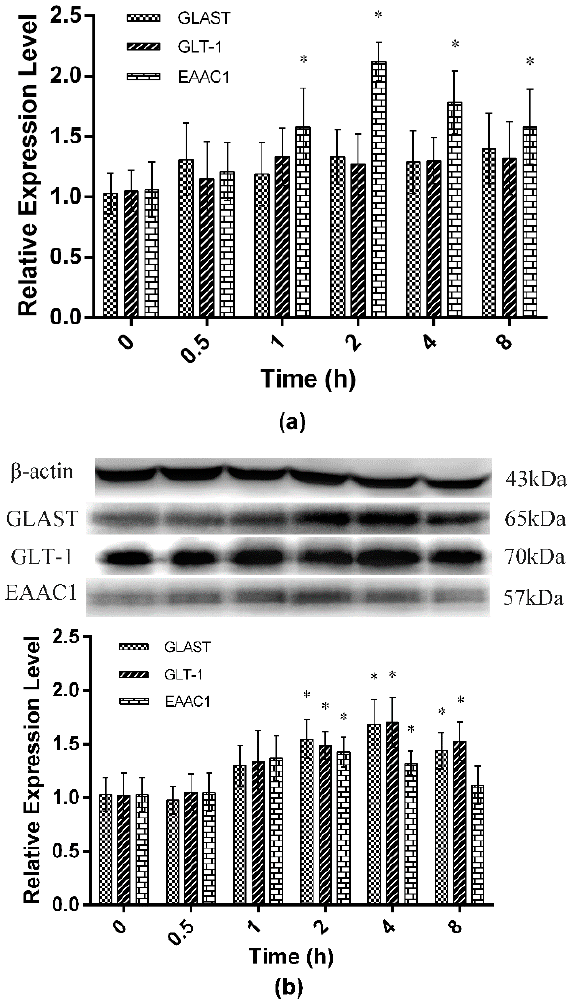
Figure 2. The expressions of the spinal GTs after single EA (Mean ± SD, n = 6). Samples were collected from the L4-5 segment of spinal cord. ( a ) MRNA expression; ( b ) protein expression. The significance of differences was calculated by a t -test. * p < 0.05 compared with 0 h within the same group.